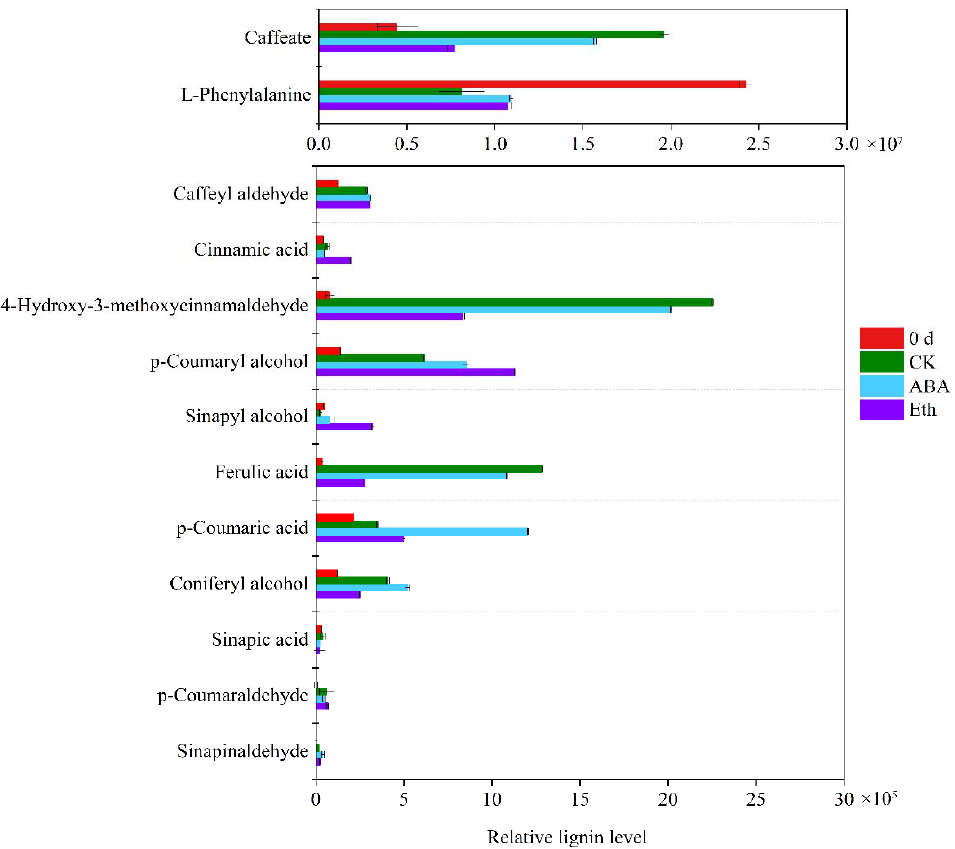
Figure 4. Metabolome analysis of effects of ABA and Eth in lignins contents.